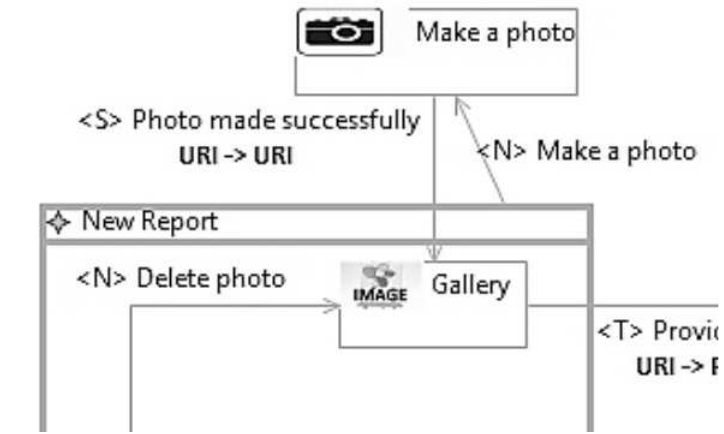
Figure 3. Part of the model in AergiaML from task